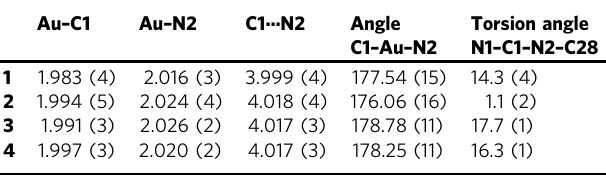
Table 1 Structural parameters of gold CMA complexes.